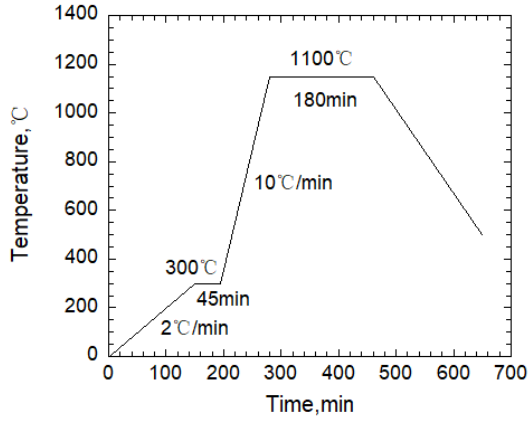
Figure 2. Sintering process of the MHSs. Table 2. The physical parameters and chemical composition of the metal hollow spheres (MHSs).